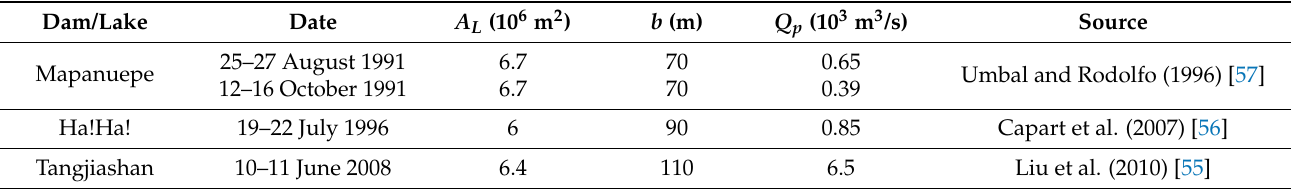
Table 3. Information on dam breach events from literature [38].